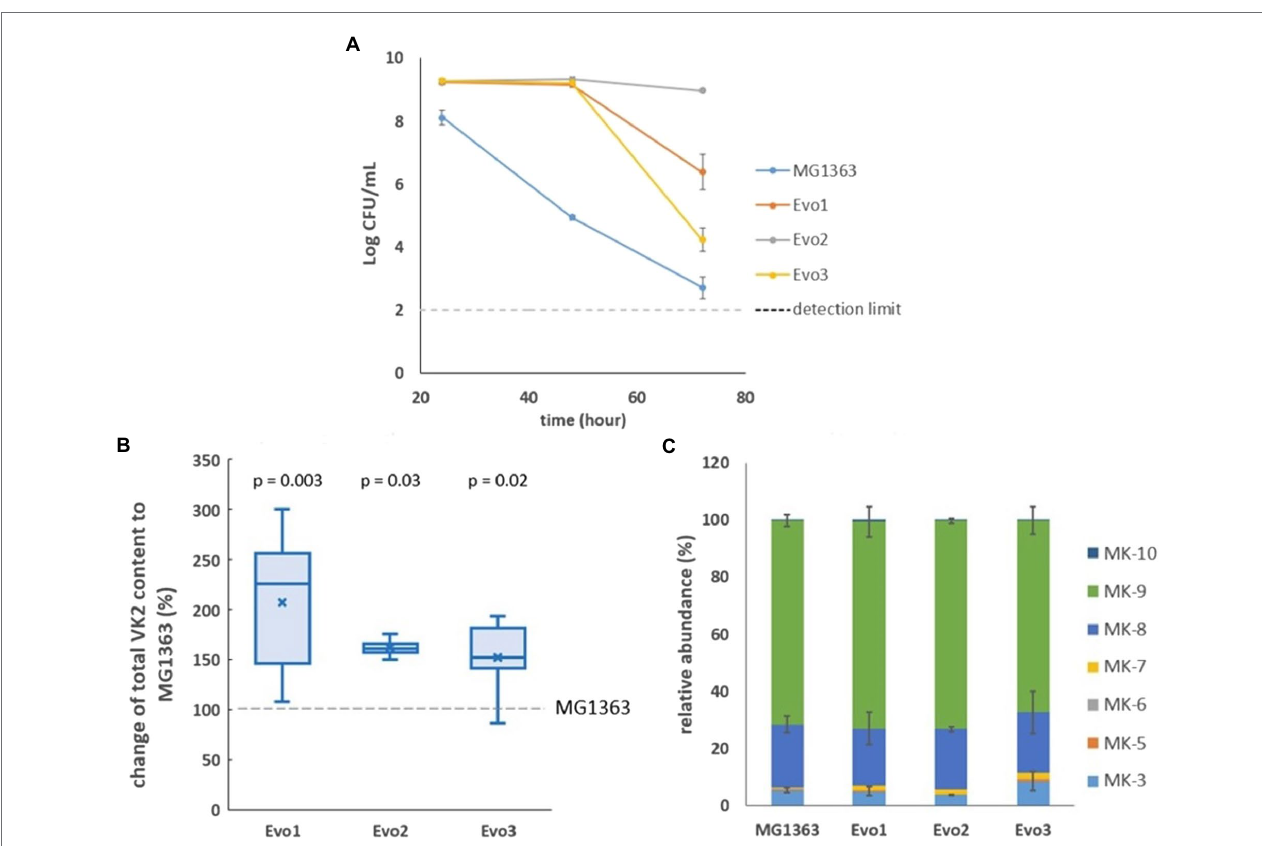
FIGURE 1 | Selection of strains. (A) Viable plate count of MG1363 and three evolved strains under aerated conditions after 24-, 48-, and 72-h cultivation in GM17 media at 30 ° C. Data from biological triplicates, error bars represent SD. (B) Differences of vitamin K2 (VK2) content in three evolved strains comparing to strain MG1363, under static fermentation condition for 48 h in GM17 media at 30 ° C. Data from four independent experiments, differences in percentage were calculated from each experiment. Crosses represent mean values in the graph; p -values of each strain compared to MG1363 were calculated by paired t -tests. (C) Relative abundance of different menaquinone forms in strain MG1363 and evolved strains under static fermentation condition for 48 h in GM17 media at 30 ° C. Data from two independent experiments, error bars represent